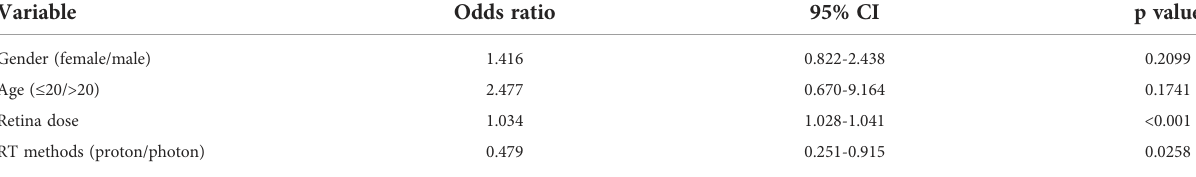
TABLE 5 Multivariate logistic regression analysis of presence of a sense of Light